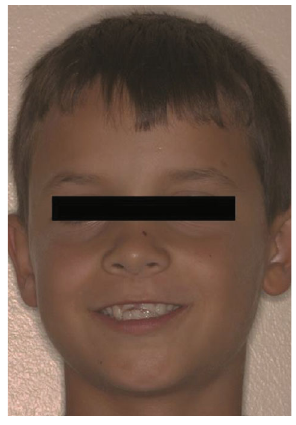
Figure 3: Frontal view of the patient.